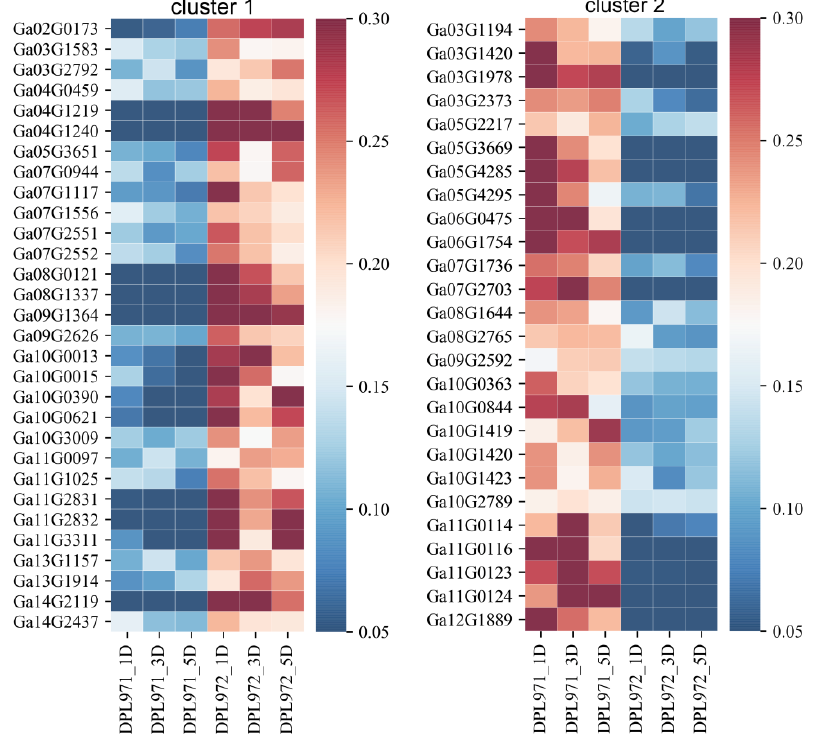
Figure 8. The expression heatmaps of hub genes in the MEmagenta module. The right side of figure represents the relative transcription abundances (based on FPKM). The gene IDs were listed on the left and sample names were displayed on the bottom.